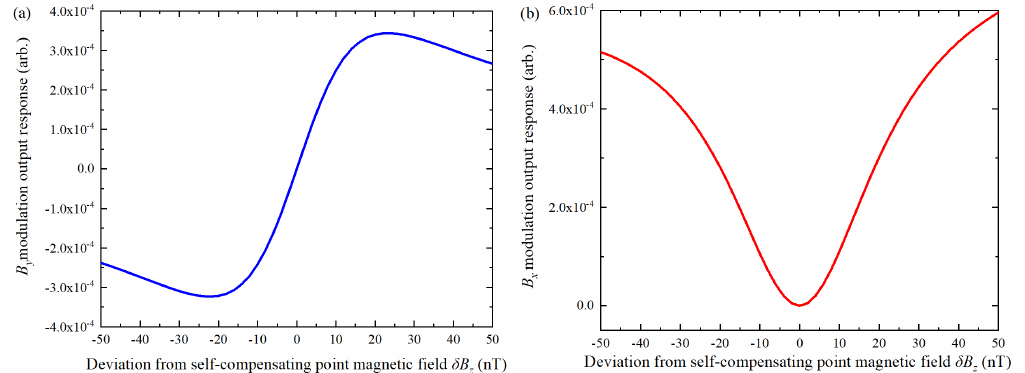
Figure 1. B y and B x step magnetic field modulation output response of SERF co-magnetometer. ( a ) B y modulation output response at different residual magnetic fields. ( b ) B x modulation output response at different residual magnetic fields.